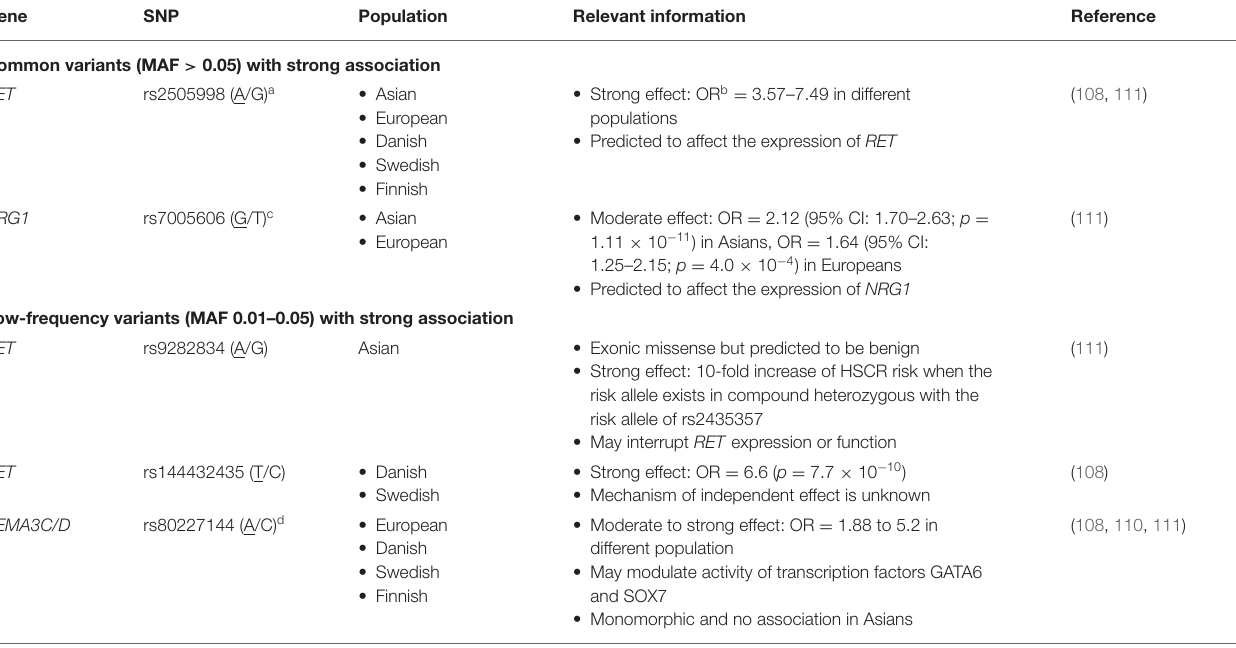
TABLE 2 | Major GWAS loci associated with HSCR. Population Relevant information